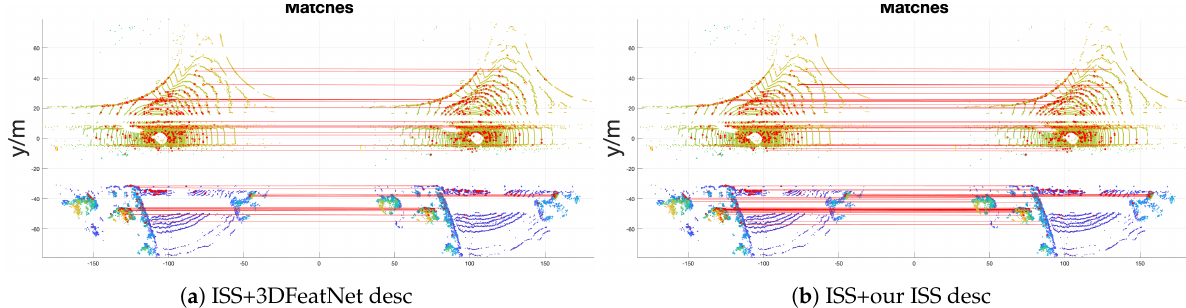
Figure 5. KITTI data geometric registration success sample. Keypoints are plotted with red dots on the point cloud. Red lines represent the matching between